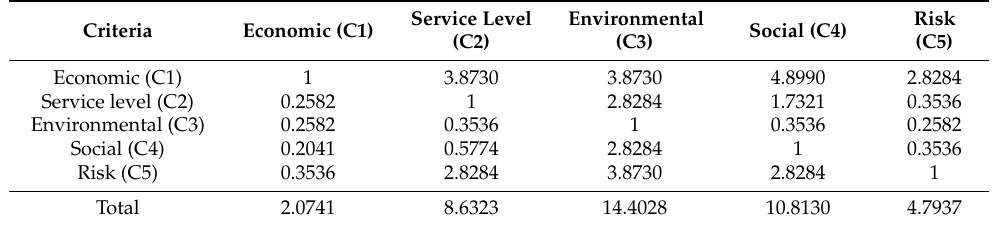
Table 7. The non-fuzzy comparison matrix of FAHP